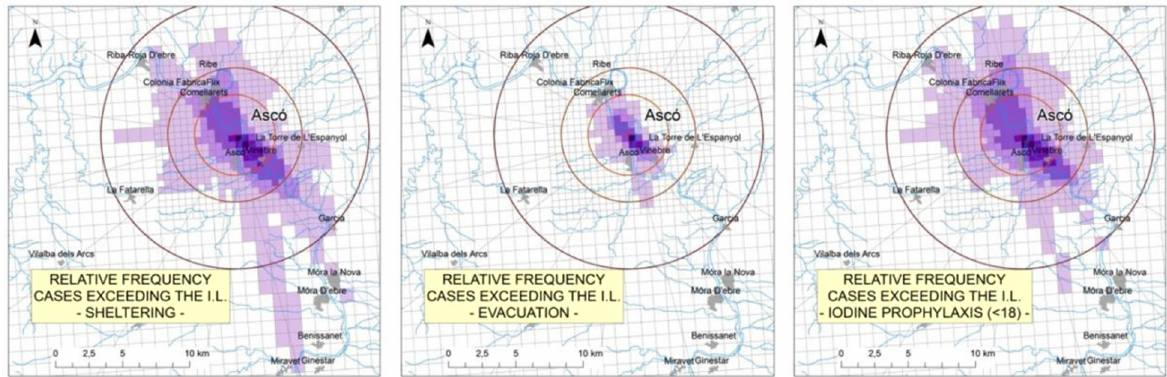
Fig. 1. Frequency of scenarios exceeding Spanish